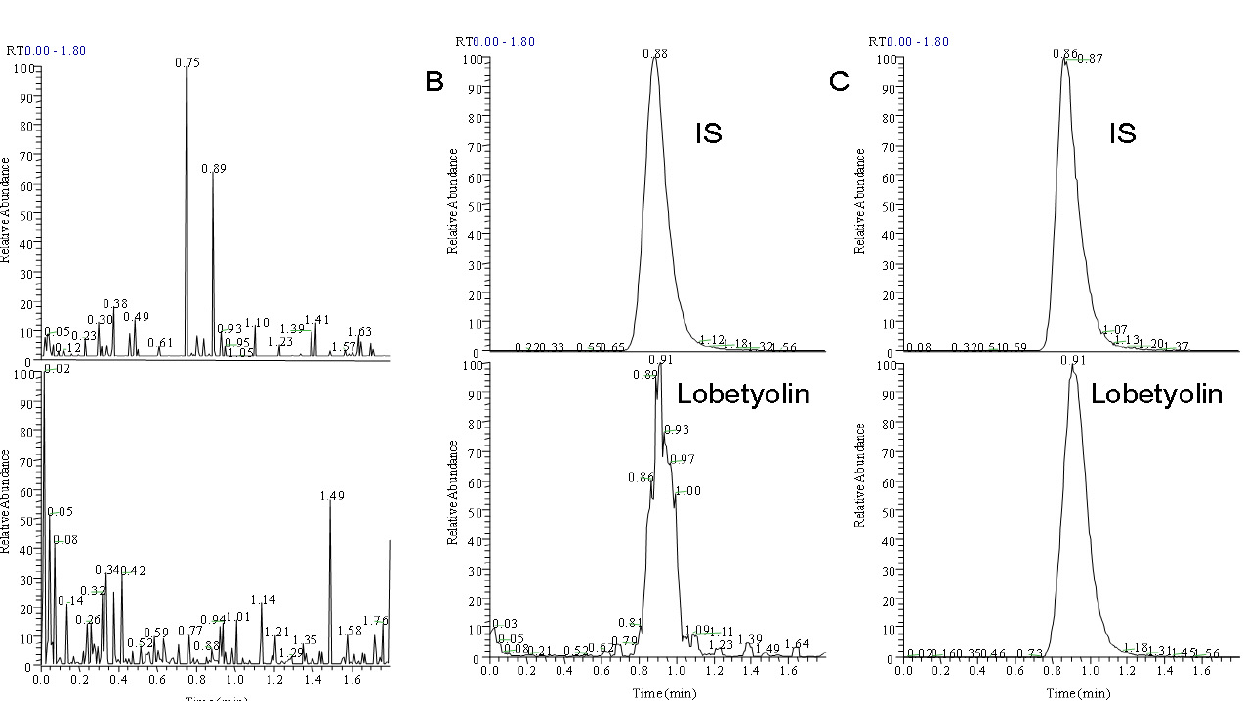
FIGURE 2 - Representative MRM chromatograms (A) blank rat plasma; (B) blank rat plasma spiked with lobetyolin and IS; (C) real plasma sample 1 h after oral dose of 10